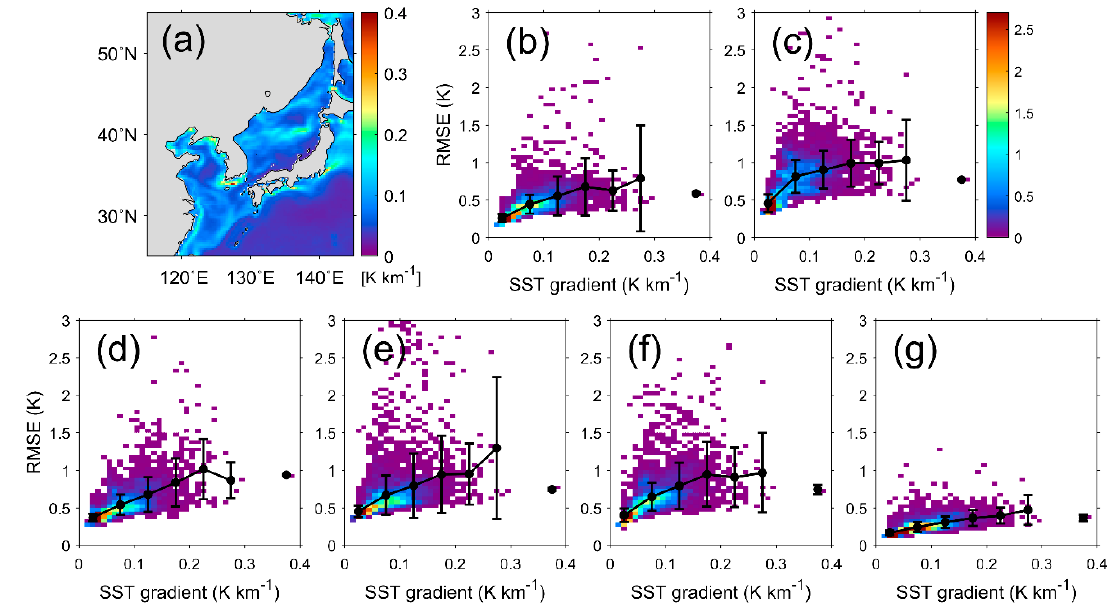
Figure 14. ( a ) Spatial distribution of sea surface temperature (SST) gradient using the OSTIA, and root-mean-squared errors for the ( b ) CMC analysis, ( c ) OISST, ( d ) REMSS analysis, ( e ) MURSST, ( f ) MGDSST, and ( g ) Blended SST for the OSTIA, as functions of the SST gradient. The color represents the percentage of the data to the total number in each bin.